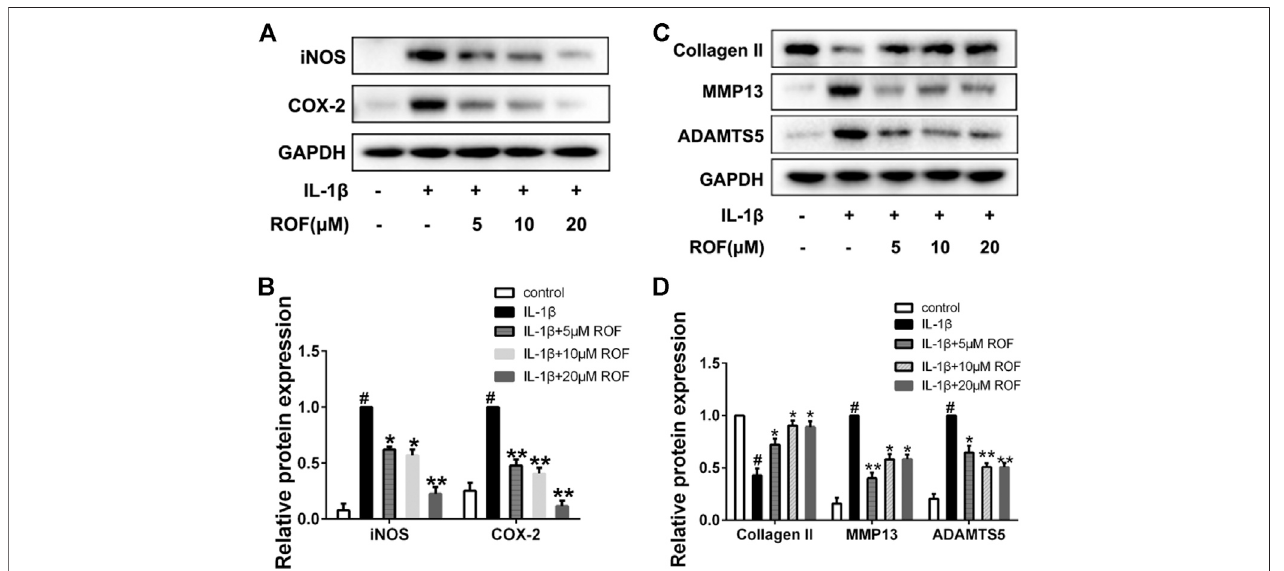
FIGURE2| ROFinhibitsIL-1 β – inducedin fl ammatoryresponsesandcartilagedegradationinchondrocytes.CellsweretreatedwithdifferentconcentrationsofROF in the presence or absence of IL-1 β (10 ng/ml) for 24 h. (A) Western blots and (B) quantitative analysis of iNOS and COX-2. (C) Western blots and (D) quantitative analysis of collagen Ⅱ , MMP13, and ADAMTS5. GAPDH was employed as the loading control ( n (cid:2) 3). # p < 0.05 vs. control group; * p < 0.05 and ** p < 0.01 vs. IL- 1 β group.